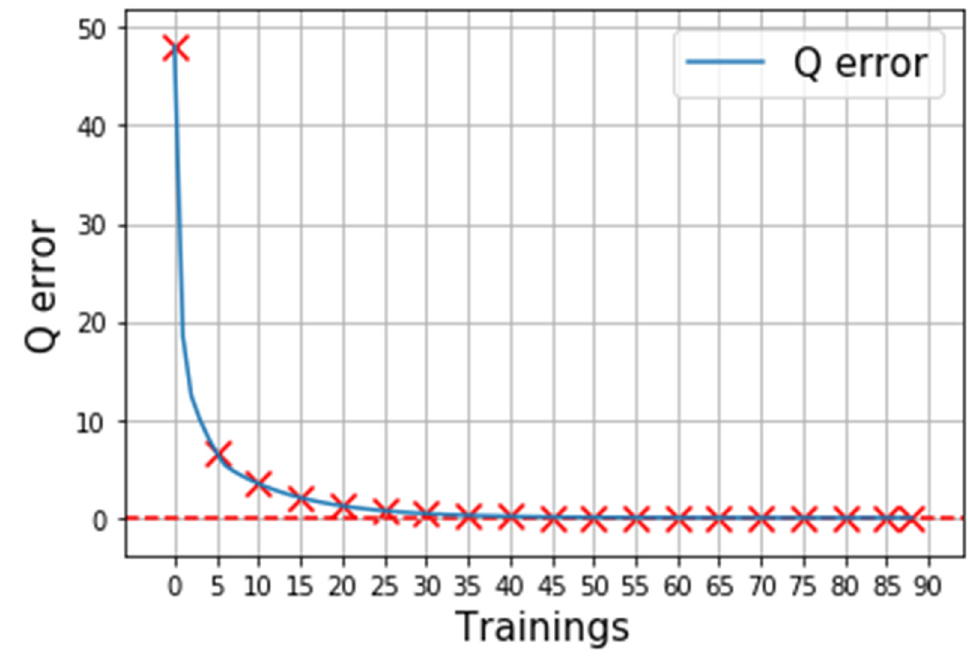
Figure 10. Training